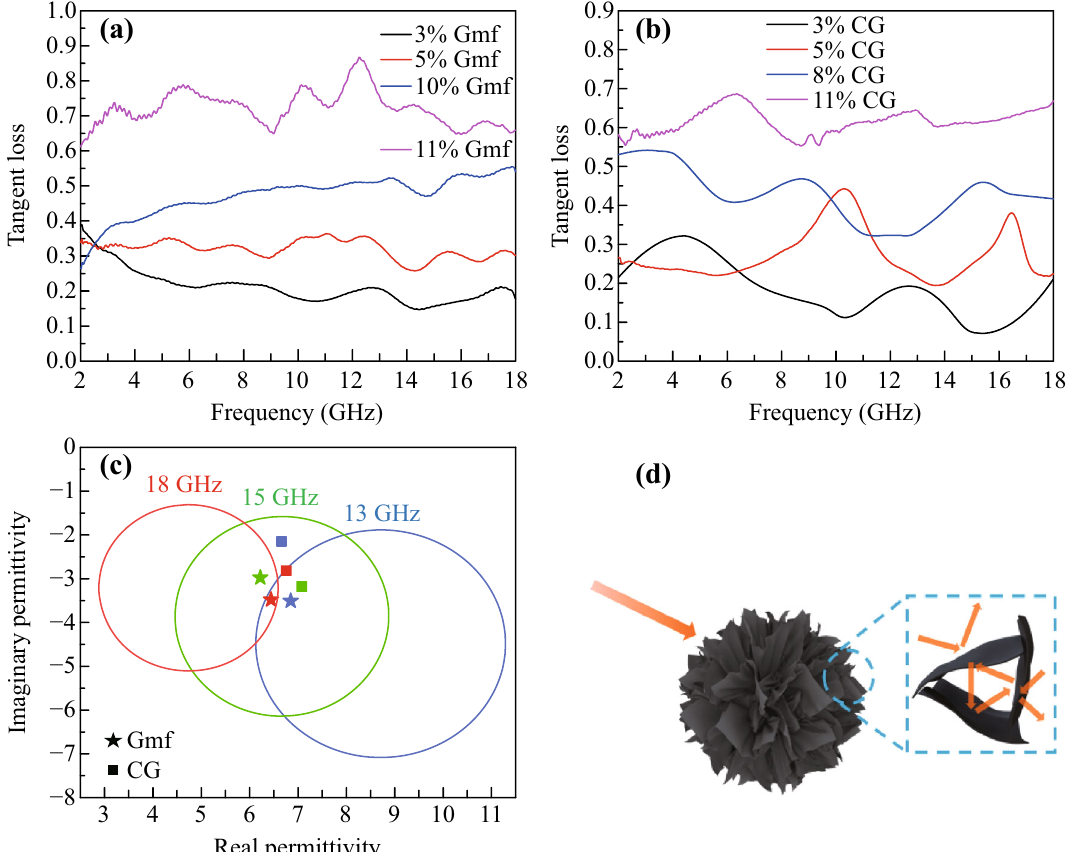
Fig. 5 a Tangent loss of Gmfs/paraffin under different filler contents. b Tangent loss of CG/paraffin under different filler contents. c Real parts and imaginary parts of 10 wt% Gmfs/paraffin and 8 wt% CG/paraffin in 13, 15, and 18 GHz. The colored circles represent the rational ranges of e 0 and e 00 to make RL lower than - 10 dB in corresponding frequency. d Schematic illustration of MA mechanism of